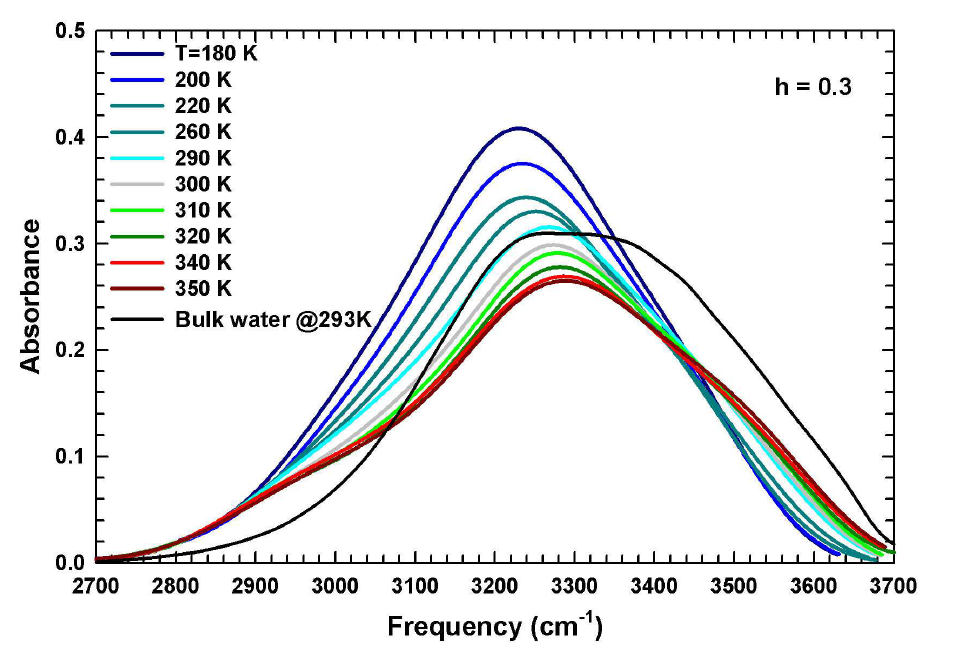
Figure 6. The O–H stretching vibrational band of hydrated lysozyme with h = 0.3 at several temperatures in the range 180 K < T < 350 K. The data of bulk water at 293 K (black line) are also reported for comparison. Figure adapted from Reference